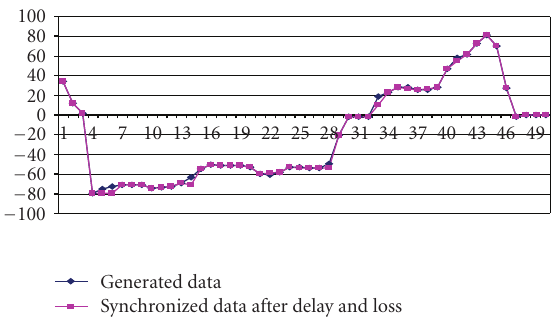
Figure 13: (a) Variable Delay unsynchronized data. (b) Variable Delay synchronized data.